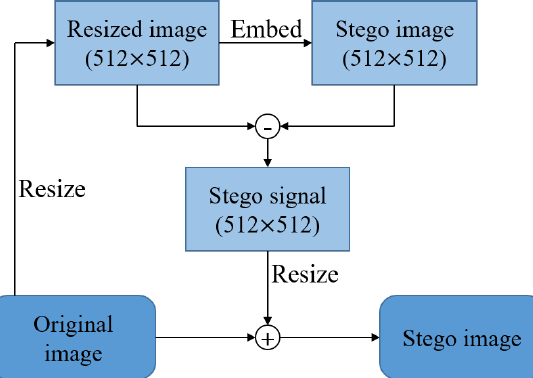
Figure 7. The process of inserting a template and watermark into images of various